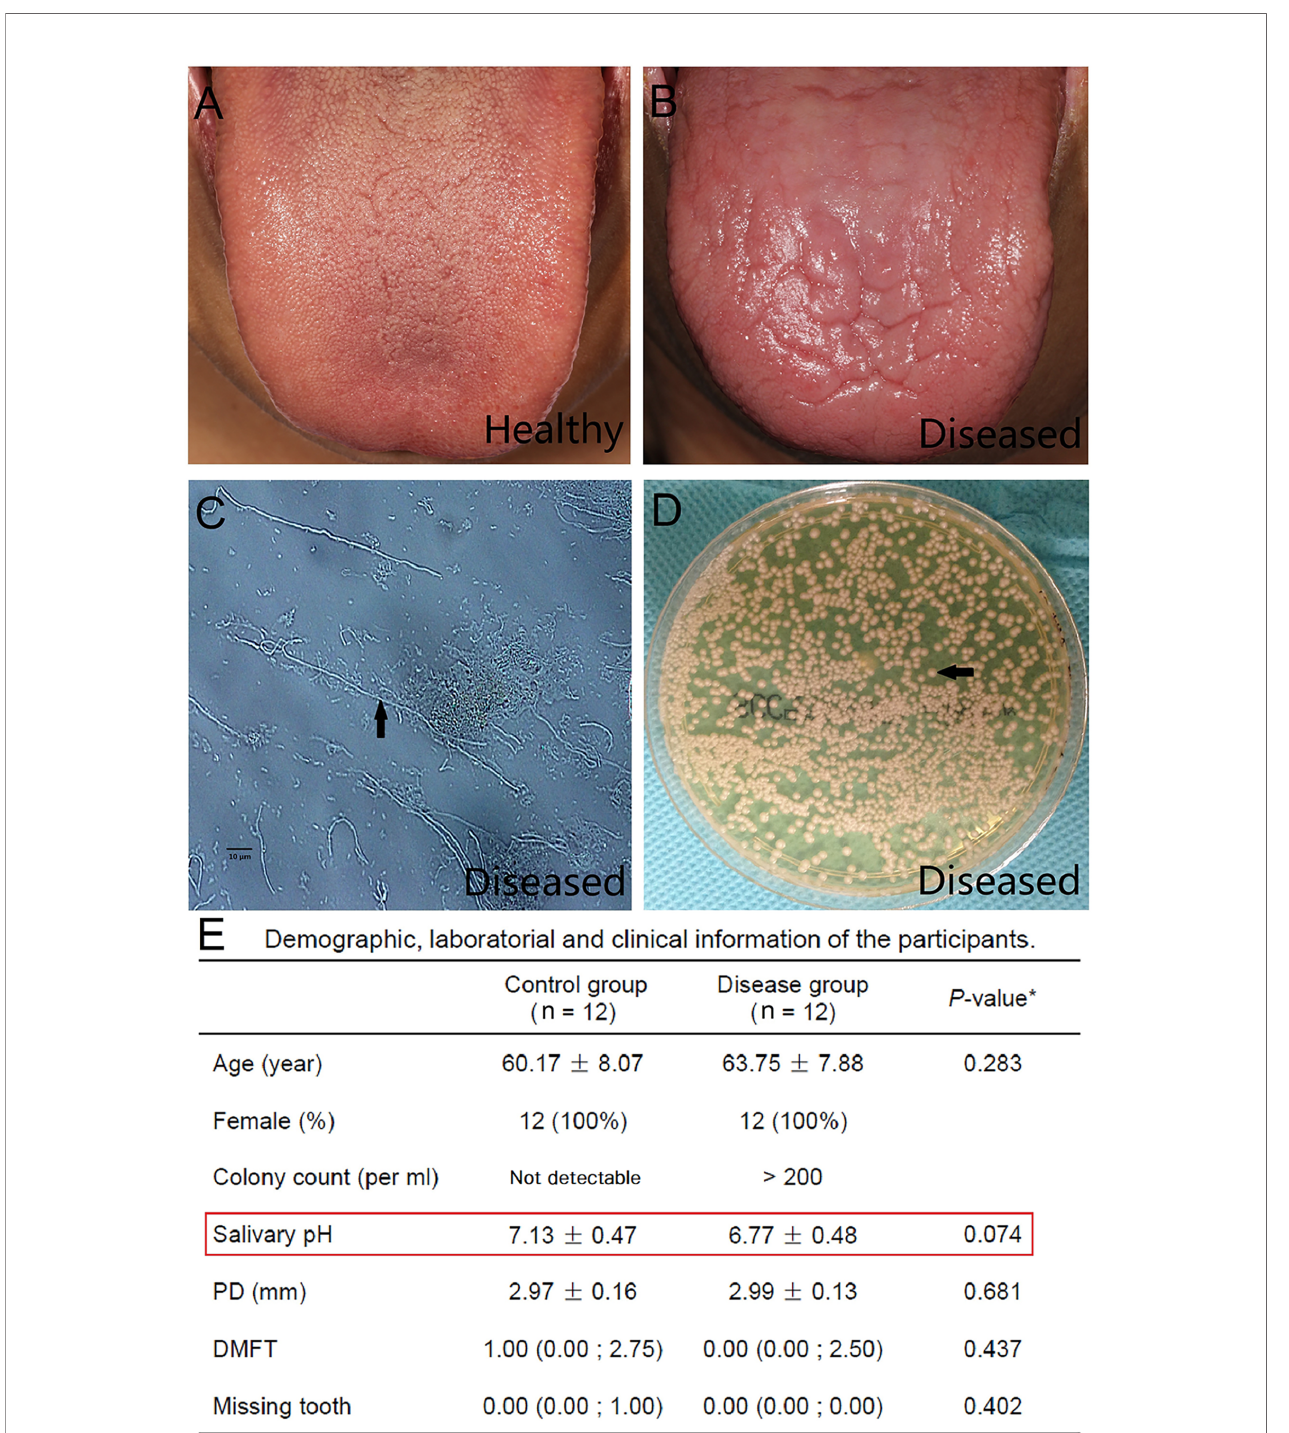
FIGURE 1 | Clinical, laboratory and demographic characteristics of the study participants. (A) A clinical picture of the normal dorsum of tongue from a healthy individual. (B) A clinical picture of the dorsum of a tongue with chronic erythematous candidiasis from the disease group. Atrophy of the fi liform papilla and erythema of the tongue could be observed. (C) Many hyphae (arrow) were detected by a smear test using optical microscopy (original magni fi cation ×400). (D) A positive result of a salivary culture obtained from Sabouraud ’ s agar. Candida albicans colonies (arrow) could be detected. (E) Demographic, laboratory and clinical information of the participants. *Independent t-test for age, salivary pH and PD; Mann-Whitney test for DMFT and missing tooth. The values are the means ± standard deviations, the medians (Q25; Q75) and the numbers of participants (percentage). PD, Probing depth; DMFT, Decayed, missing and fi lled tooth.